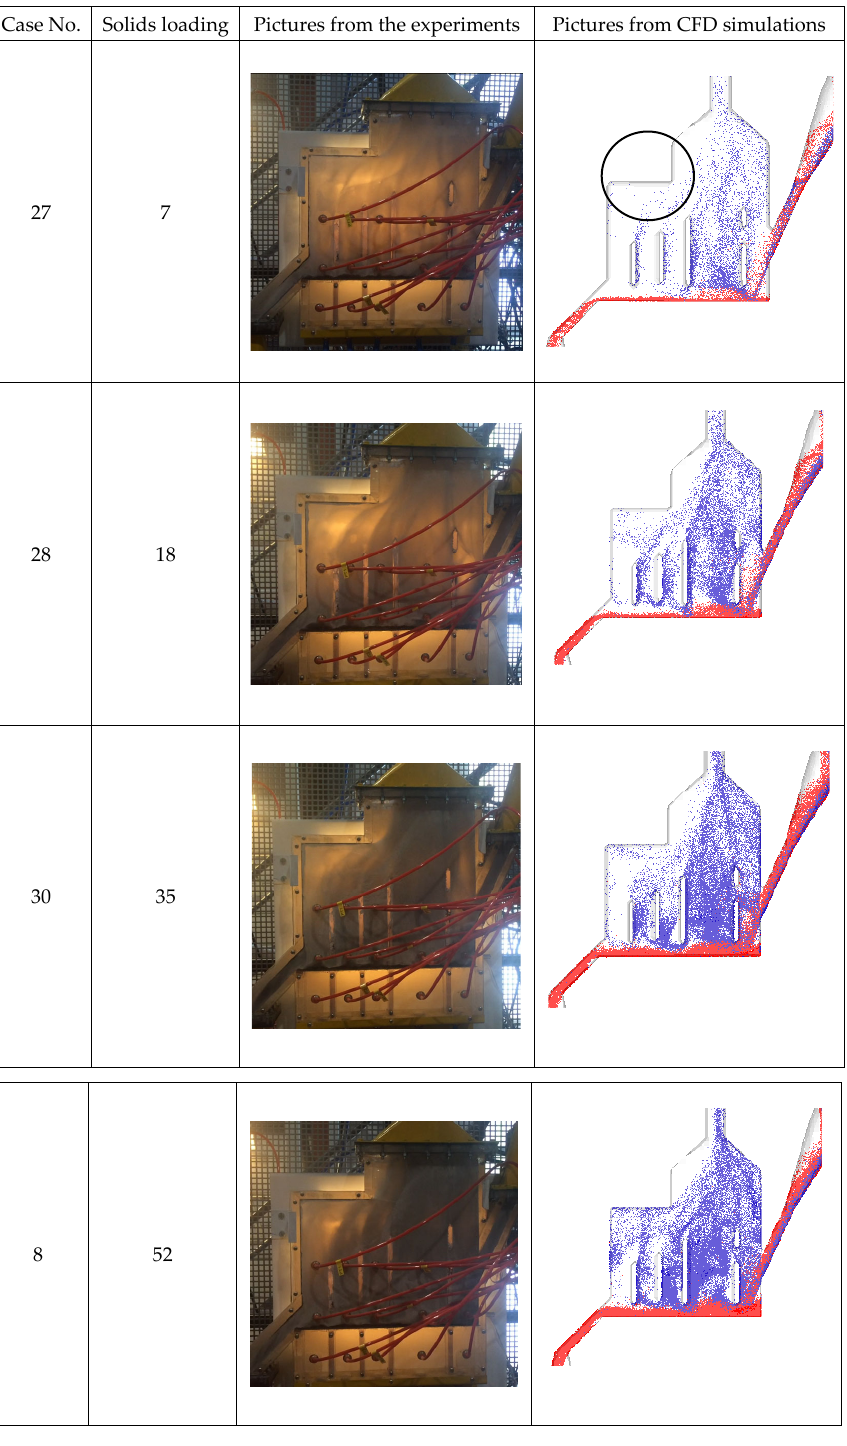
Figure 13. Snapshots for four different cases, both from experiments and from Barracuda simulations applying the WenYu model for zirconia and the Ergun model for steel .